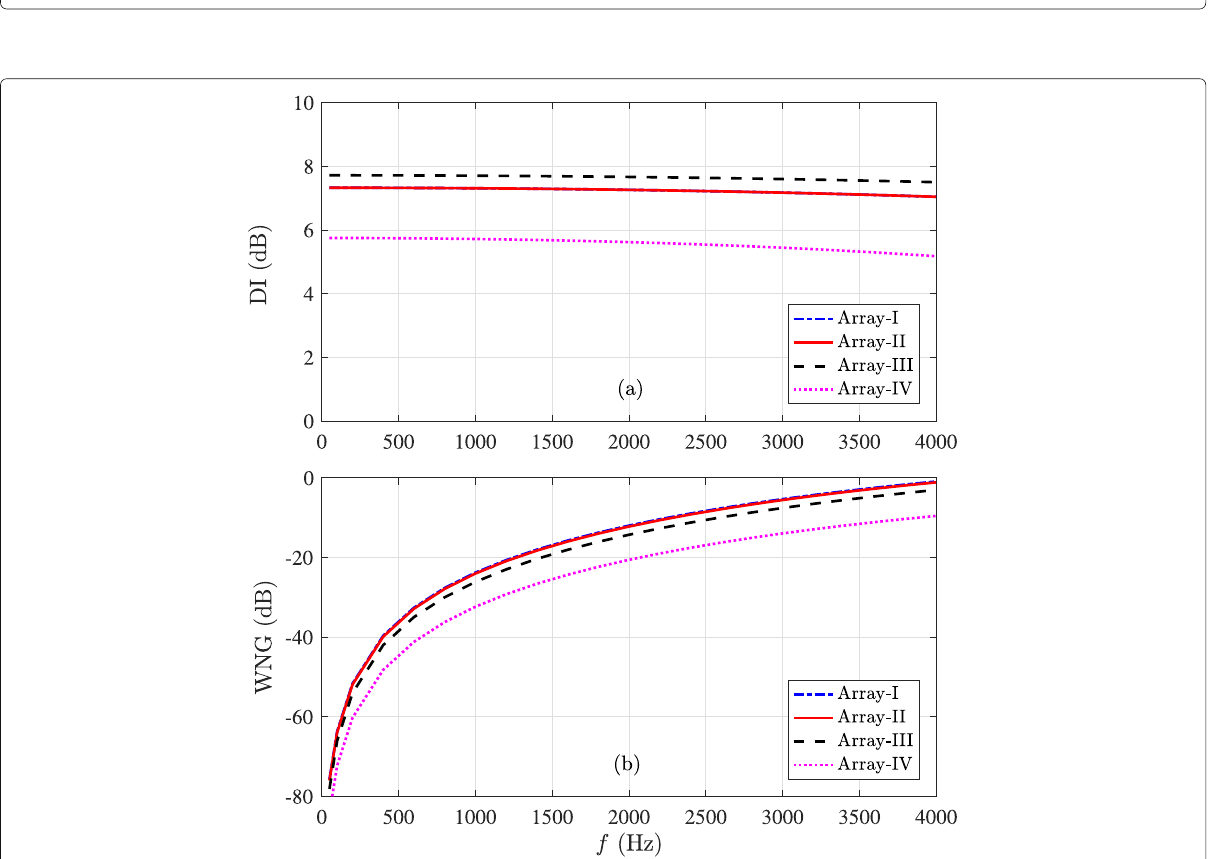
Fig. 6 DI and WNG of the second-order differential beamformer designed with four different array geometries: a DI and b